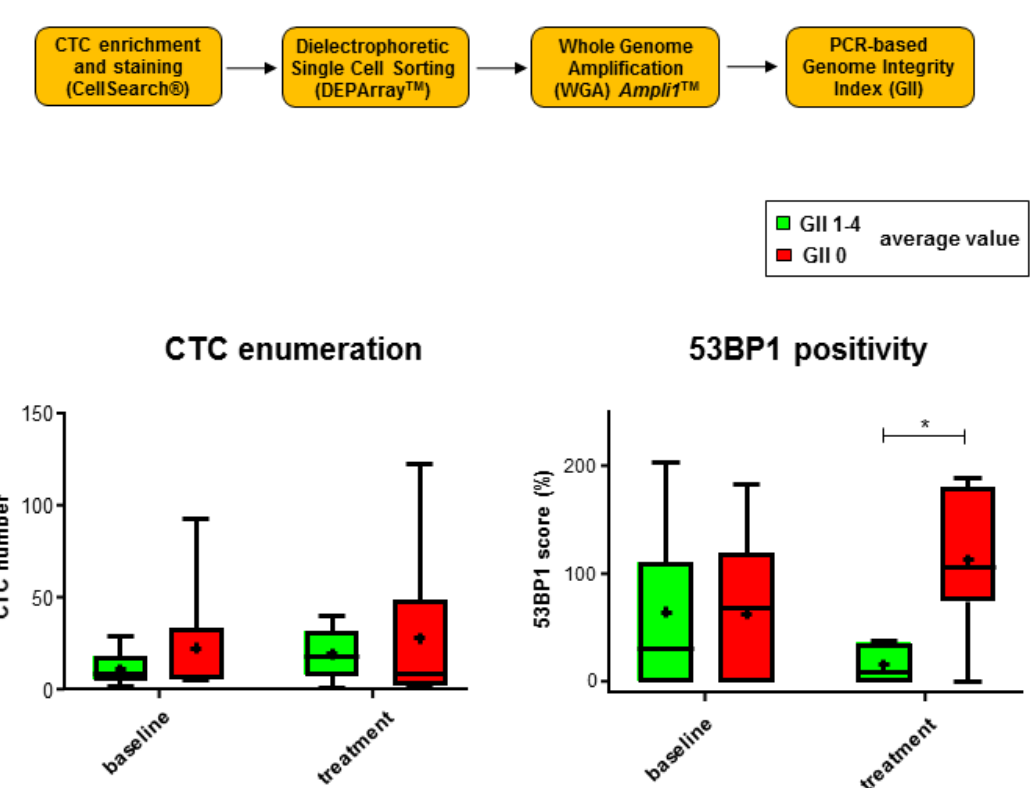
Figure 4. Analysis of genomic integrity as a function of 53BP1 scores of CTCs. The workflow for the determination of the genomic integrity index (GII) following CTC enrichment, staining, single cell sorting, whole genome amplification (WGA), and PCR is schematically drawn on the top. GII values were determined for single CTCs, and average values per sample were calculated. The lower left graph displays CTC numbers with remaining versus loss of genomic integrity for blood samples collected during baseline (GII 1–4, N = 11, and GII 0, N = 9) and treatment visits 1-2 (GII 1–4, N = 5 and GII 0, N = 6). The lower right panel shows 53BP1 scores for these four groups. Box plots show mean values (cross), the median (line), and 95% CI (whiskers). * P < 0.05, Mann–Whitney U